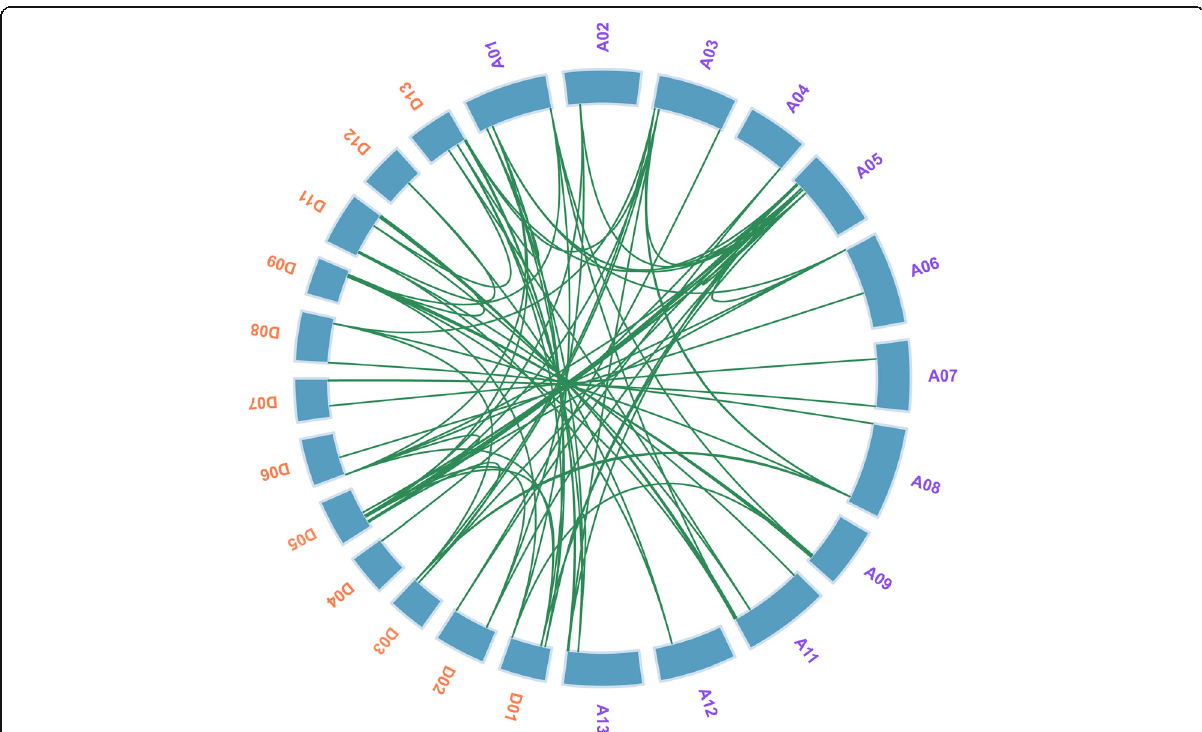
Fig. 4 The chromosome distribution and the synteny of tubulin genes in G.